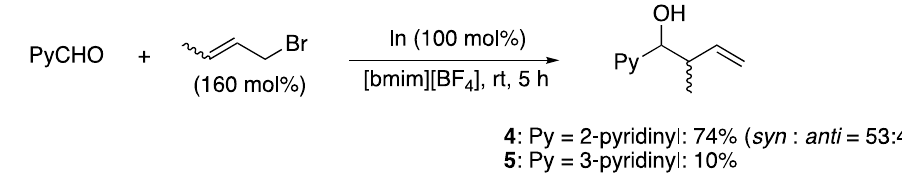
Scheme 2. Effects of intramolecular chelating units.